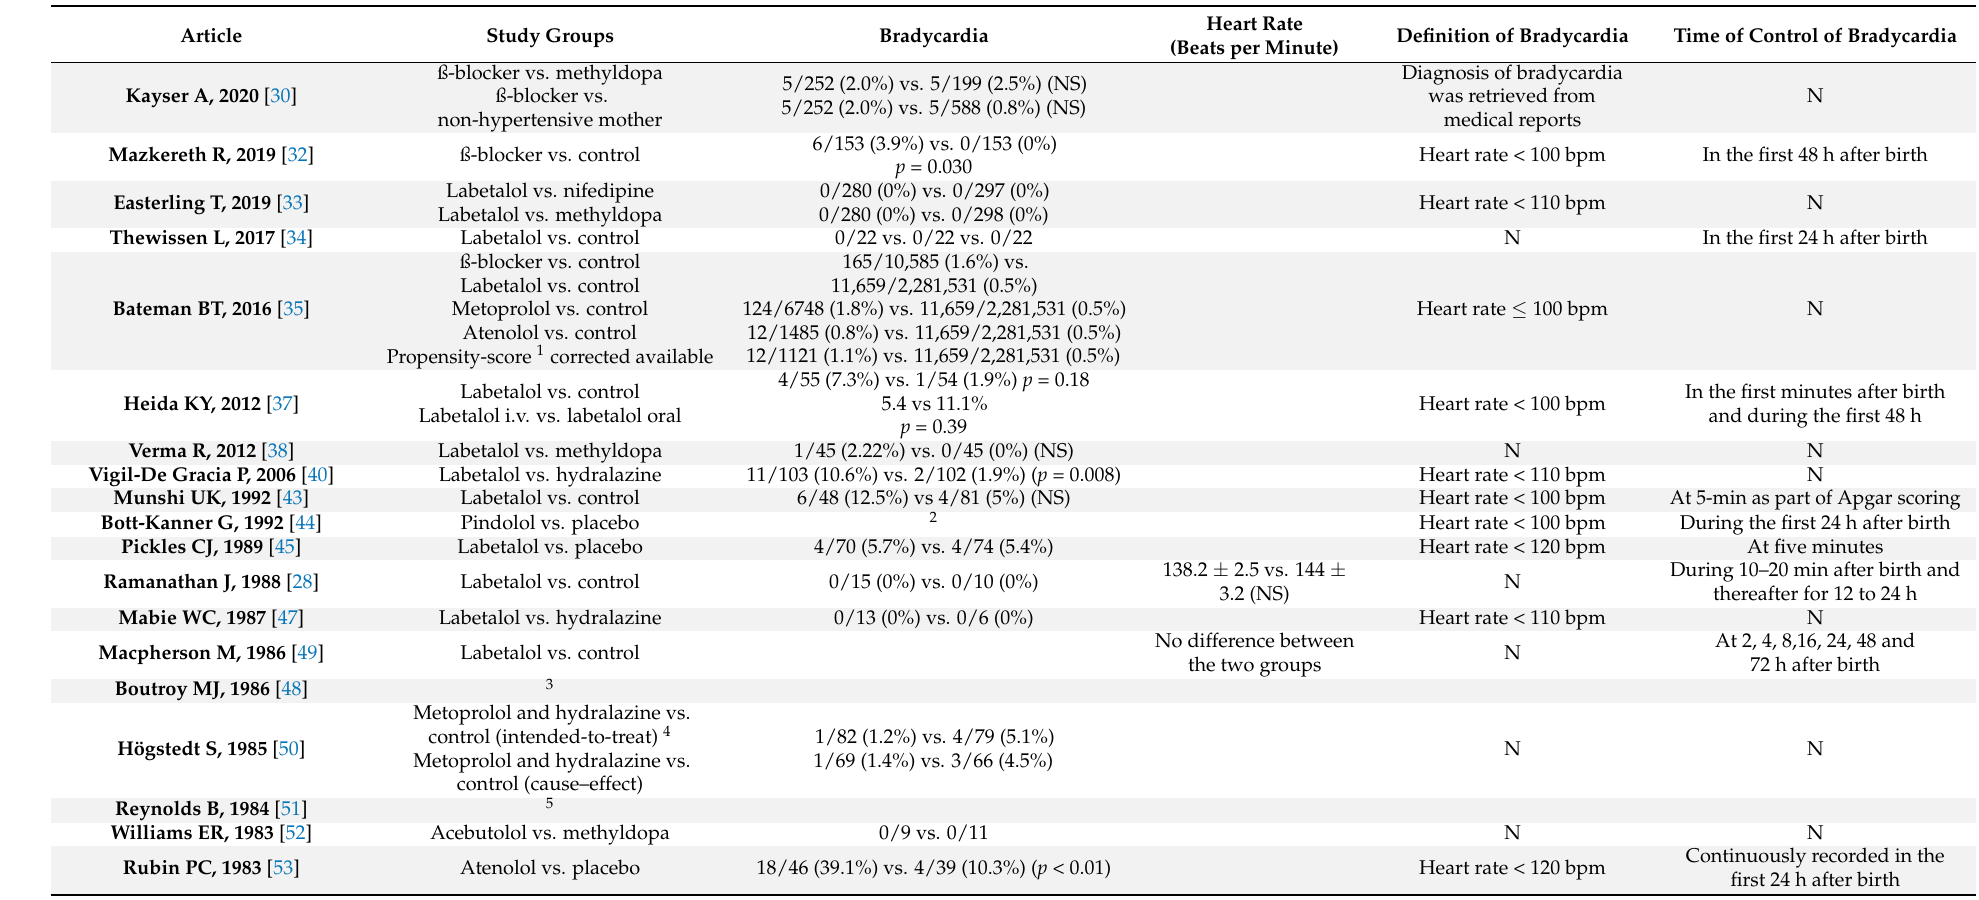
Table 8. Studies with bradycardia as outcome